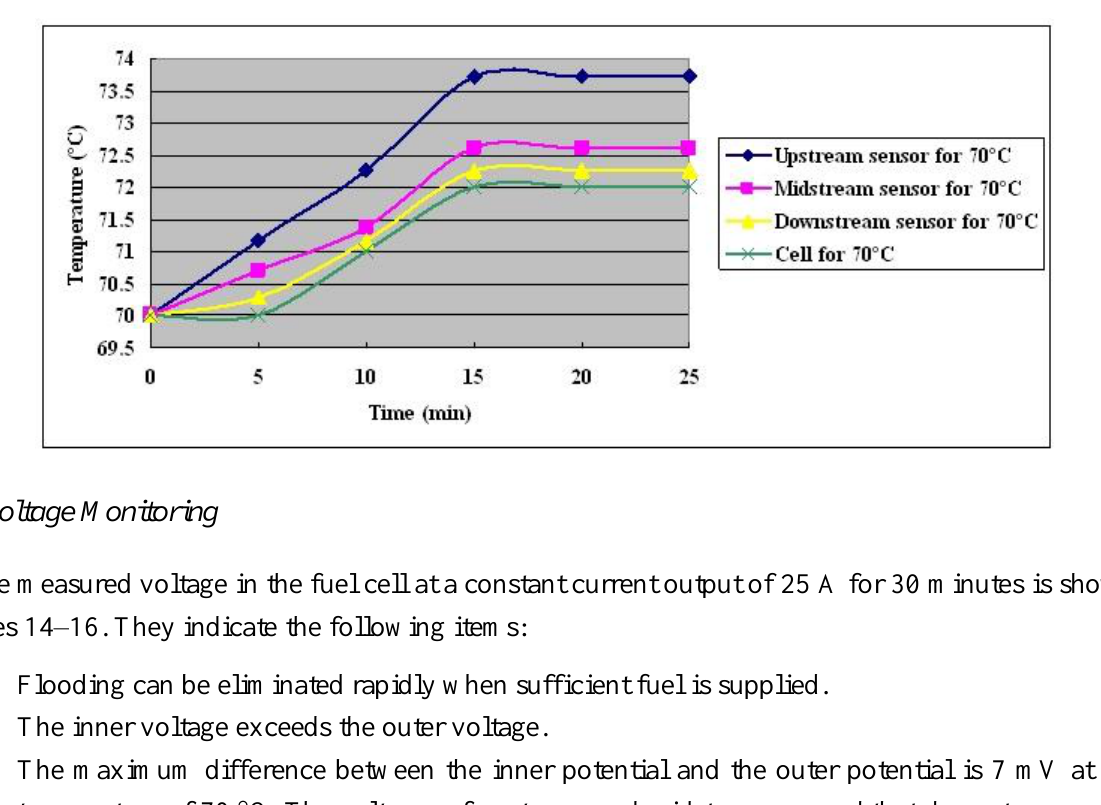
Figure 13. Temperature distributions at cell temperature of 70  C with constant output current of 25